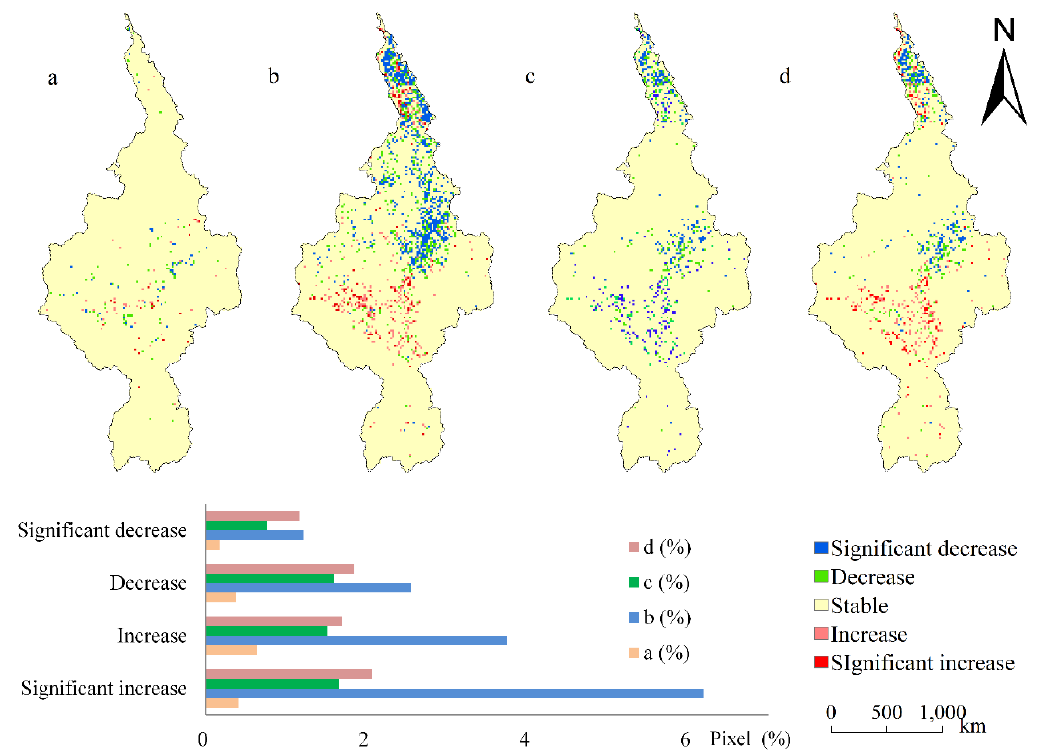
Figure 6. Temporal tendency and area percentages of the average annual soil retention service based on methods A1–A4 (1982–2013). ( a ) A1, tendency of soil retention service based on C1 (1992–2013); ( b ) A2, tendency of soil retention service based on C2 (1982–2013); ( c ) A3, tendency of soil retention service based on C3 (1982–2013); ( d ) A4, tendency of soil retention service based on C4 (1982–2013); (a%) area percentage based on (a); (b%) area percentage based on (b); (c%) area percentage based on (c); (d%) area percentage based on (d).